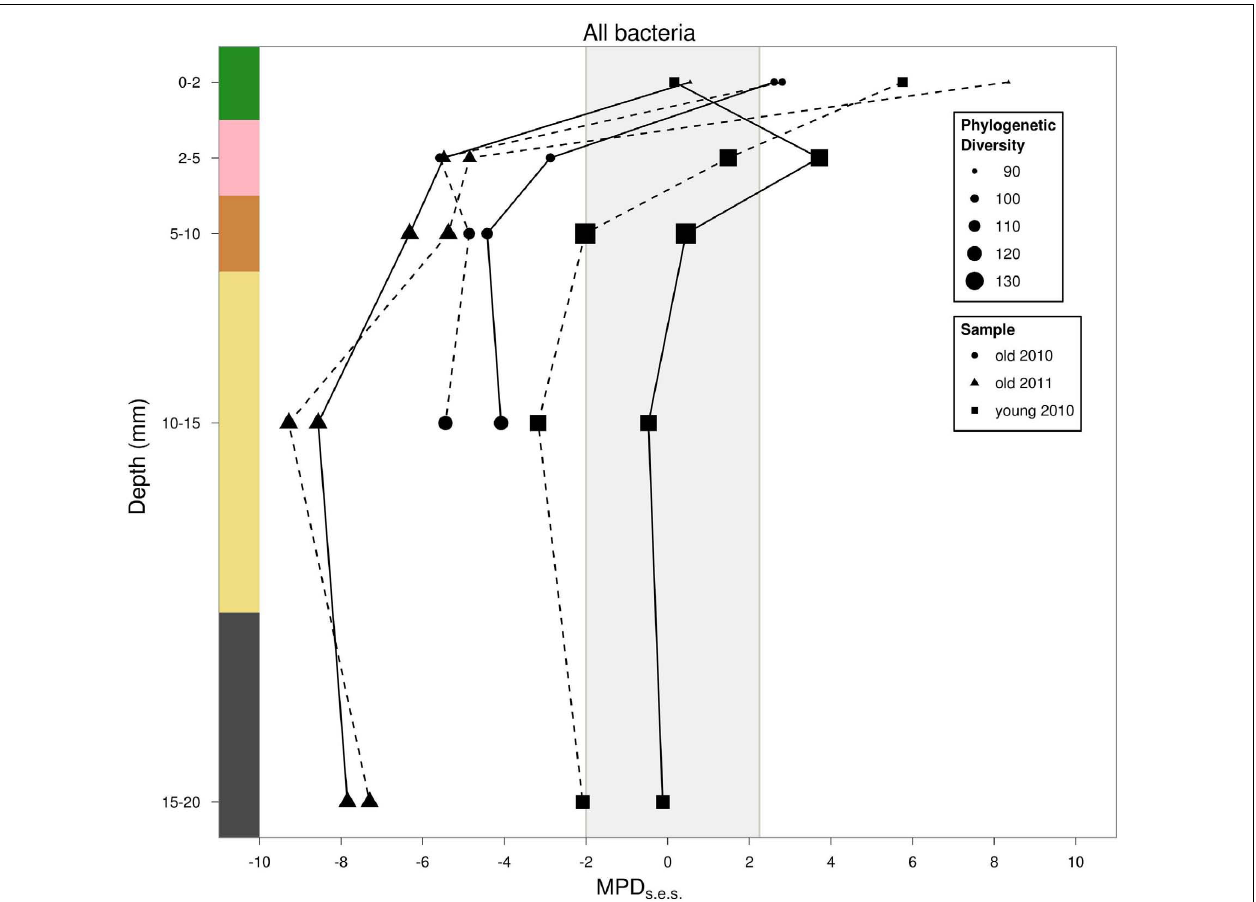
pool. Point size is scaled to phylogenetic diversity, 0 D Z ( π ).Values falling below the shaded region indicate statistically significant phylogenetic clustering. Values above this region indicate phylogenetic